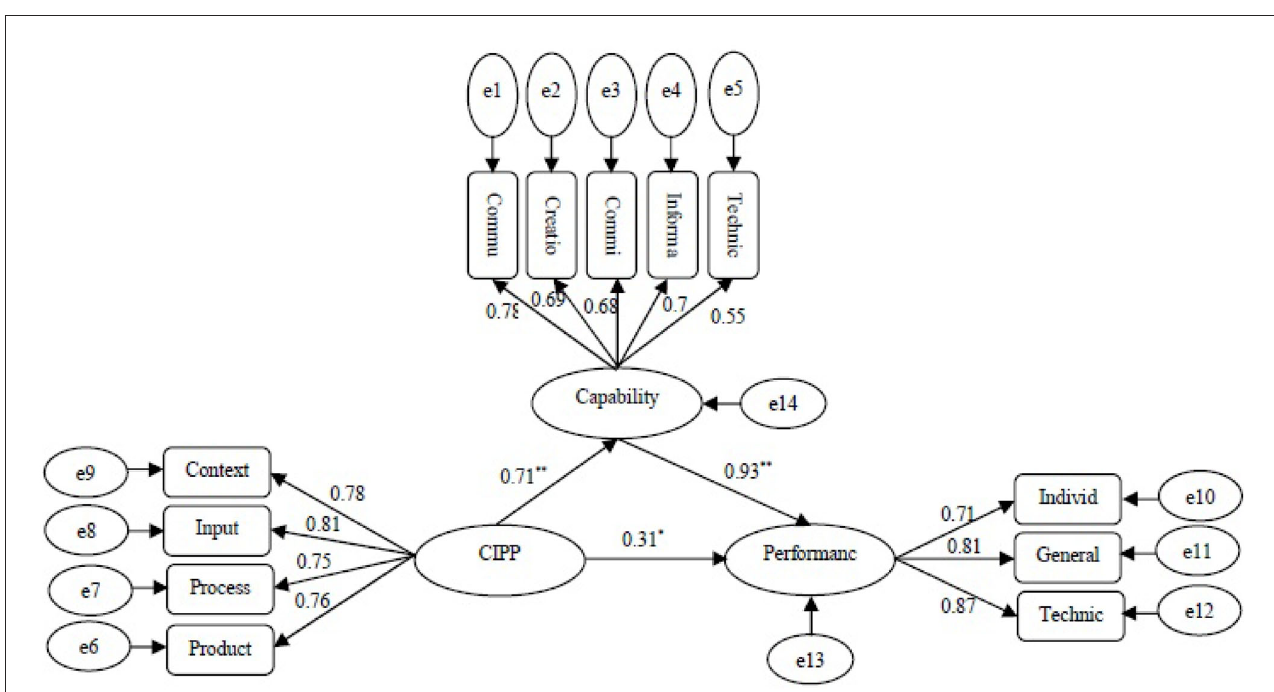
FIGURE2 The structural model of the